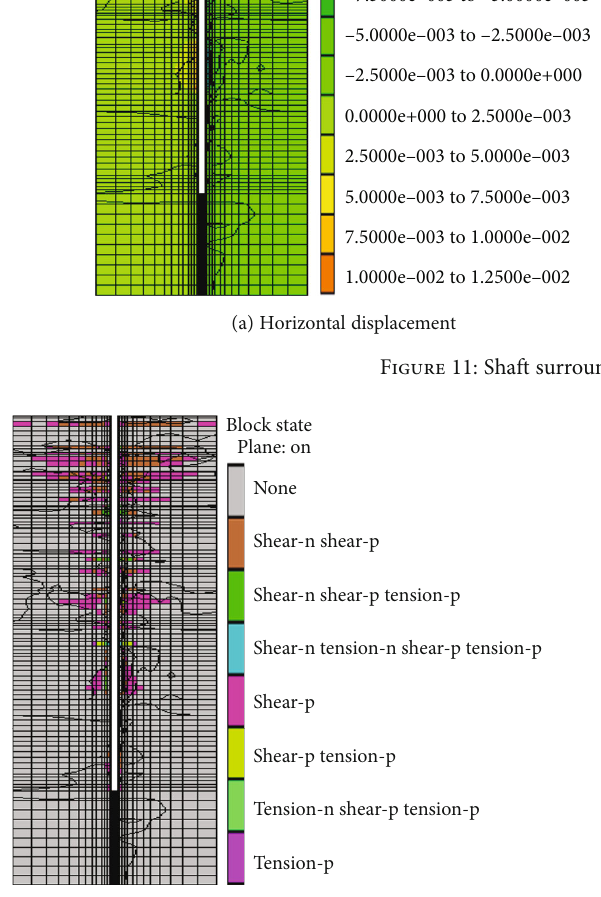
Figure 12: Plastic zone of the shaft surrounding